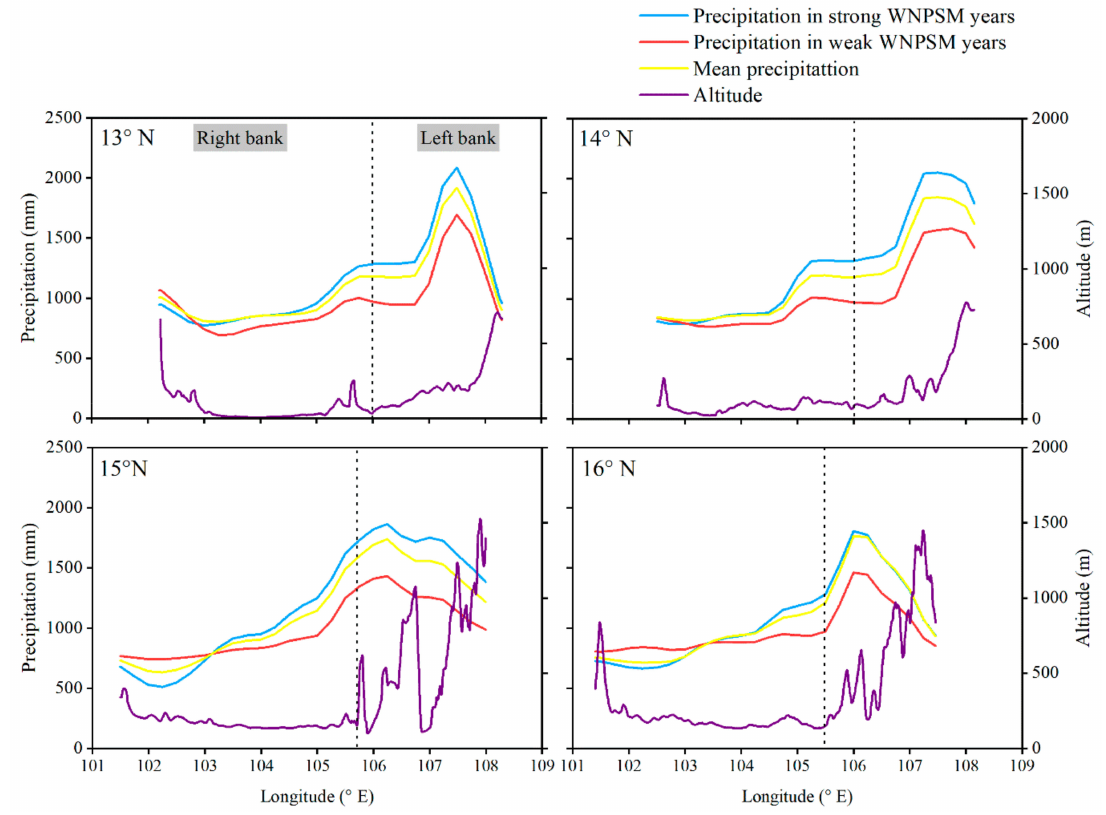
Figure 8. Precipitation during JJAS (left axis) in di ff erent types of WNPSM years, as well as altitude (right axis) along latitudinal cross sections at 13 ◦ N, 14 ◦ N, 15 ◦ N and 16 ◦